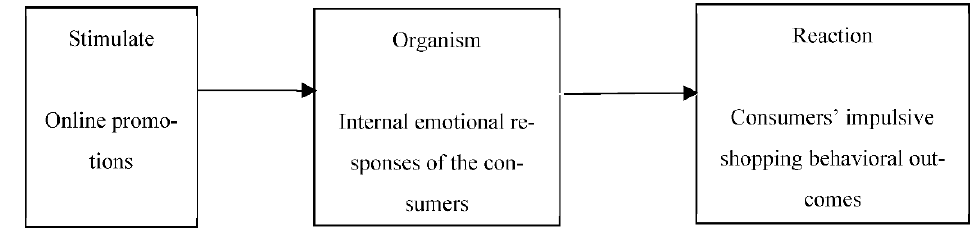
Figure 1. S–O–R model.